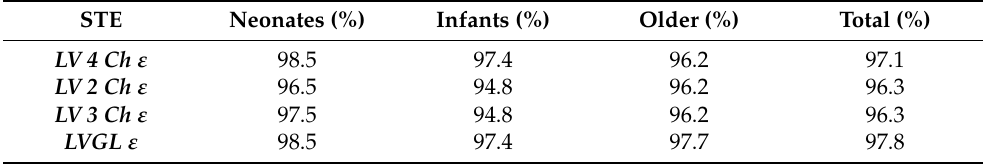
Table 2. Feasibility at different age groups.